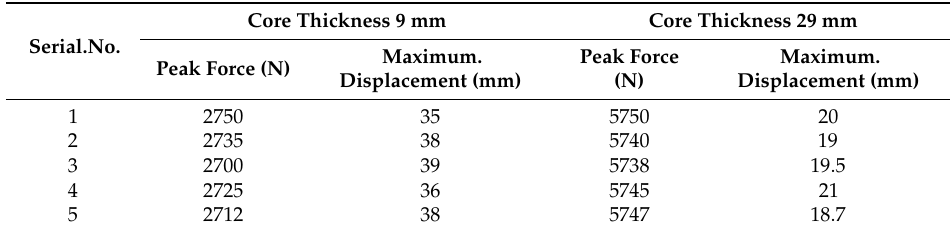
Table 3. Peak force and maximum displacement of both thick and thin cored specimens under four-point flexural